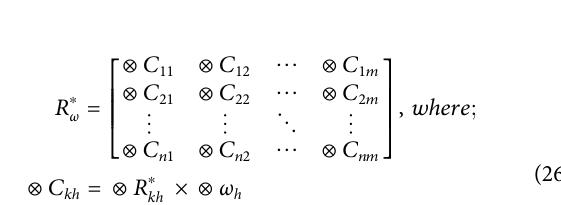
FIGURE 6 | Grey relational assessment between fossil fuel consumption and CO 2